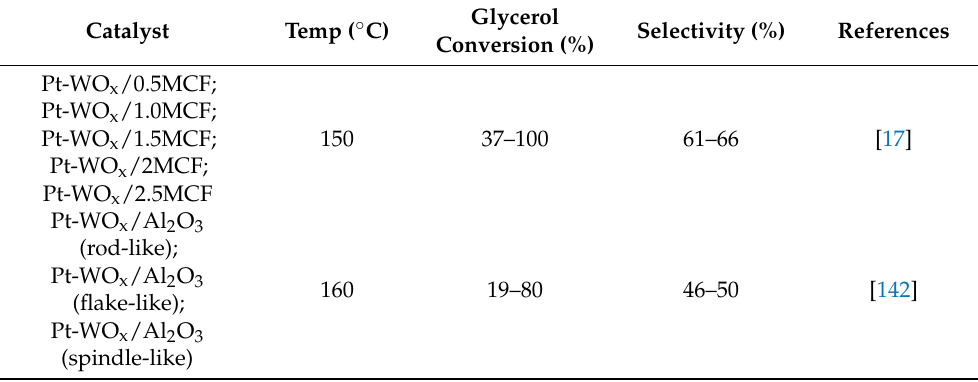
Table 6. A summary of recent studies on glycerol hydrogenolysis to